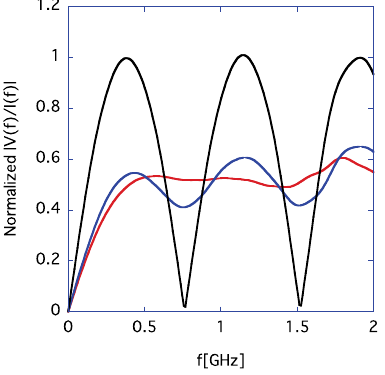
FIG. 8. The black, the blue and the red lines show the results for the electrode shapes; the rectangular one, the exponential one, and the polynomial one, respectively, where the ends are terminated with resistors in the vacuum chamber. All results are divided by the peak value at 0.38 GHz for the rectangular shape.